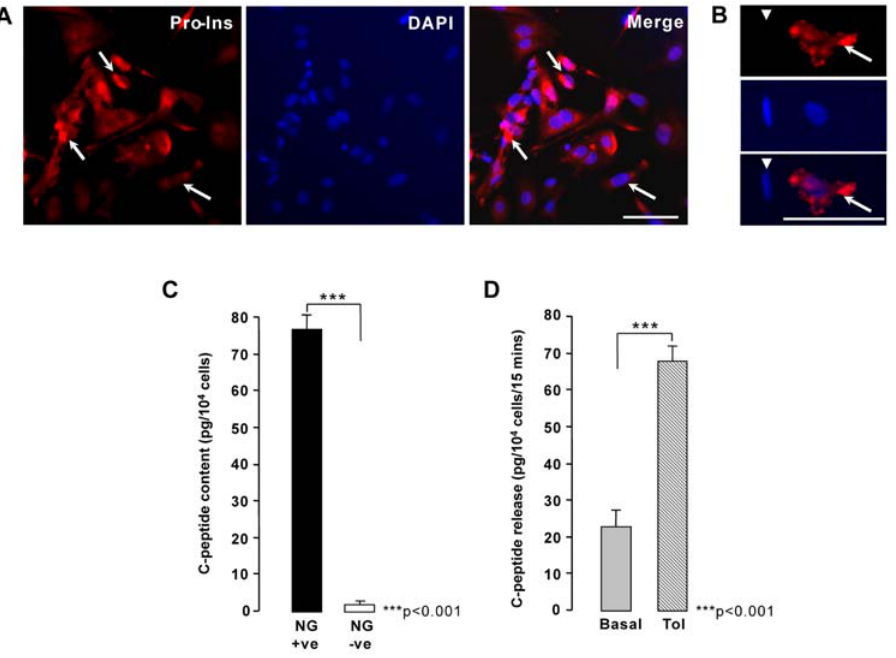
Figure 5. Insulin and C-peptide expression in FACS sorted H7.Px4 cells. H7.Px4 cells sorted for Newport green staining (Figure 4) were replated on human placental collagen VI-treated chambers and cultured for 5 days before immunocytochemistry and C-peptide analysis. (A) shows immunocytochemistry for anti-human Proinsulin antibody (red) with nuclei counterstained with DAPI. Proinsulin-positive reaction is seen scattered in cytoplasm shown in (A) and in a higher magnification in (B) (arrows). Also shown is a Proinsulin-negative cell (arrowhead). Scale bars, 50 m m. (C) and (D) summarize C-peptide content and release in response to 100 m M tolbutamide; the fraction released was 79.92 6 10.8% from three independent experiments using two H7.Px4 clones. Triple asterisk indicates p , 0.001.